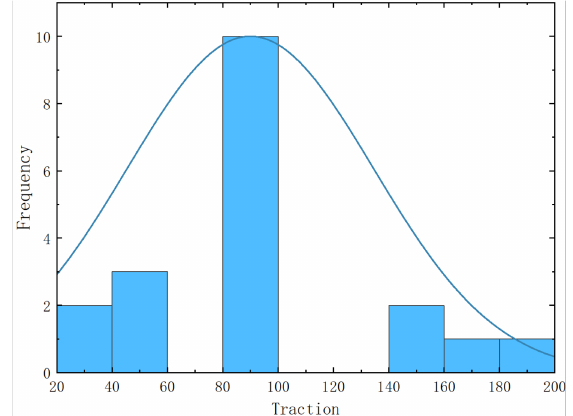
Figure 12. Graphical summary of the